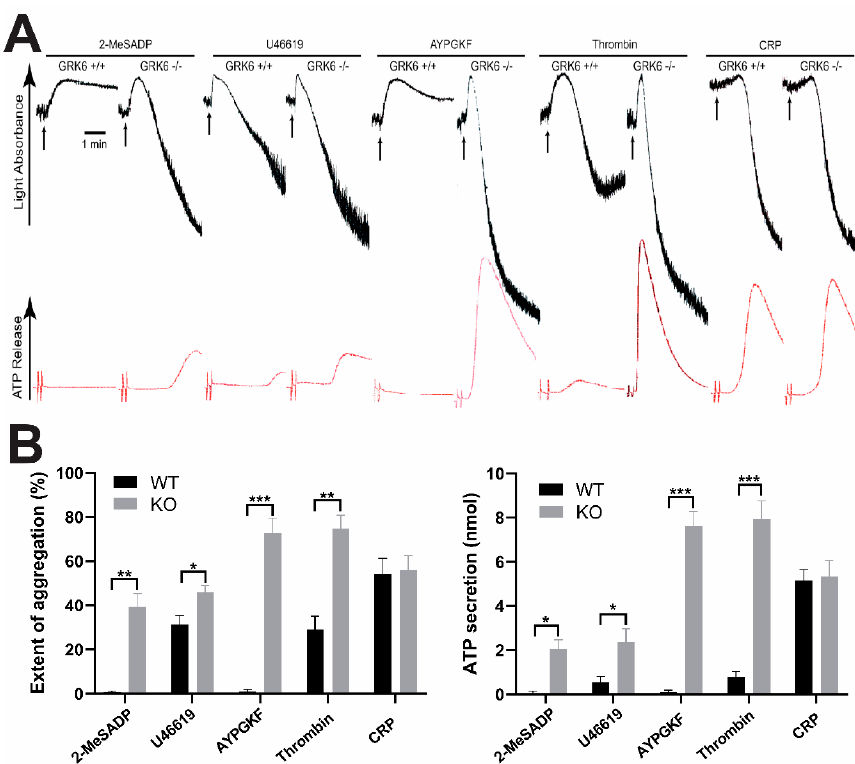
Figure 1. Agonist-induced platelet aggregation and dense granule secretion in the GPCR kinase (GRK)6-deficient platelets. Washed platelets from GRK6 − / − mice and GRK6 +/+ littermates were stimulated with G-protein-coupled receptor (GPCR) agonists 30 nM 2MeSADP, 50 nM U46619, 60 µM AYPGKF, 0.1 unit/mL thrombin and GPVI agonist 2.5 µg/mL collagen-related peptide (CRP) for 3.5 min under stirring conditions. ( A ) Platelet aggregation (top) and ATP secretion (bottom) were measured in a lumi-aggregometer. All tracings shown are representative of at least three different experiments. ( B ) Quantification of extent of aggregation and dense granule secretion from panel A. Data are presented as mean ± SE *, p < 0.05; **, p < 0.01; ***, p < 0.005.